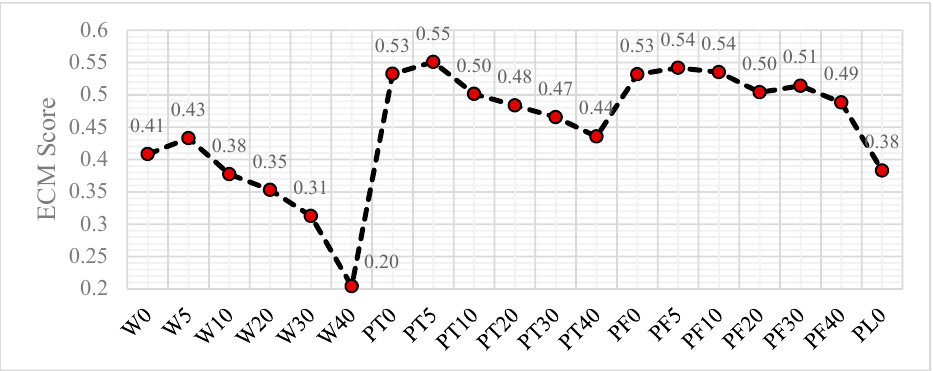
Figure 19. ECM index scores for all concrete mixes.